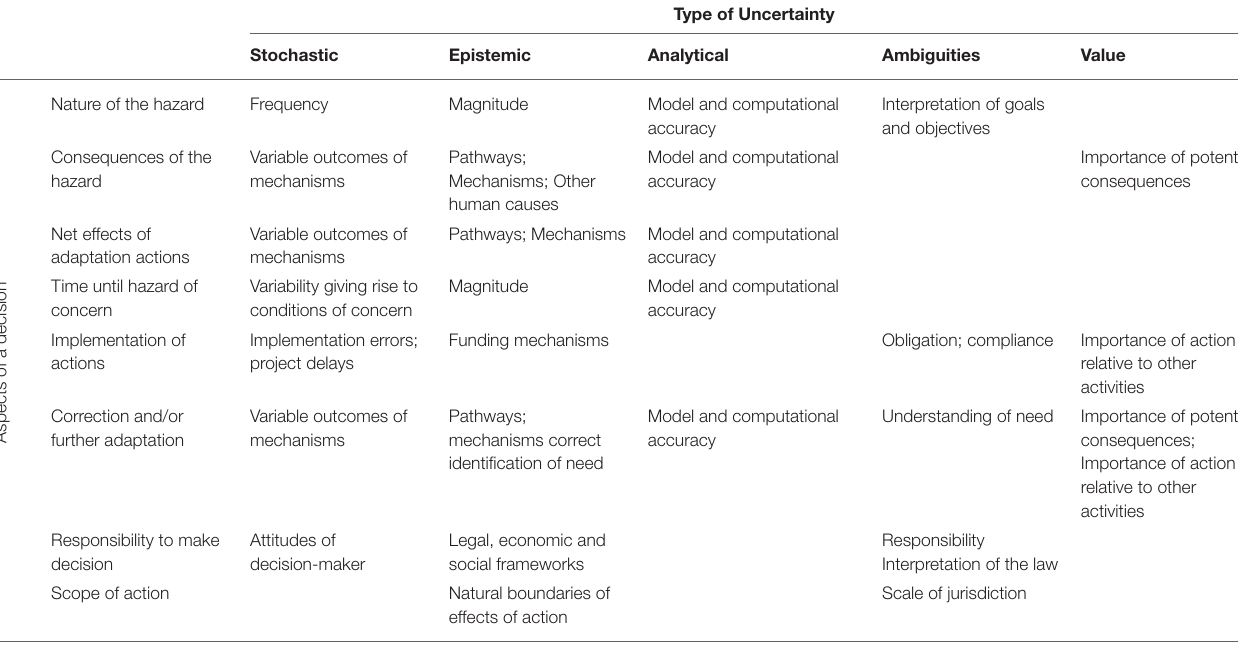
TABLE 2 | Types of uncertainty that can arise in different aspects of an analysis supporting a decision on mitigation or